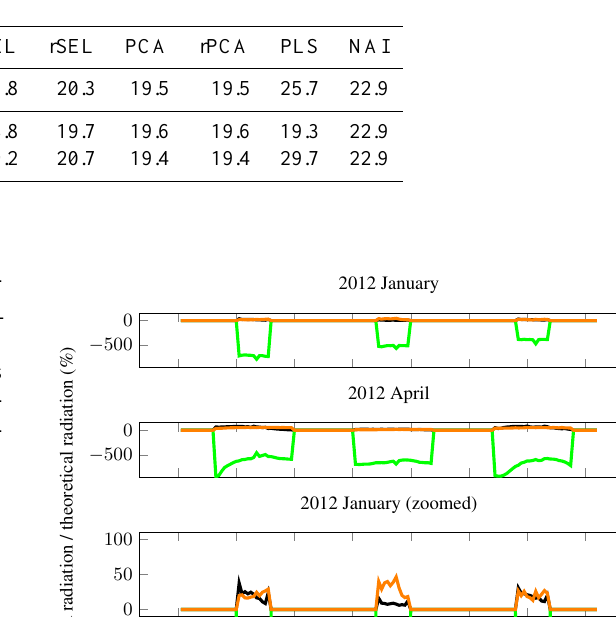
Table 4. Nowcasting errors (RMSE) on the testing data set.